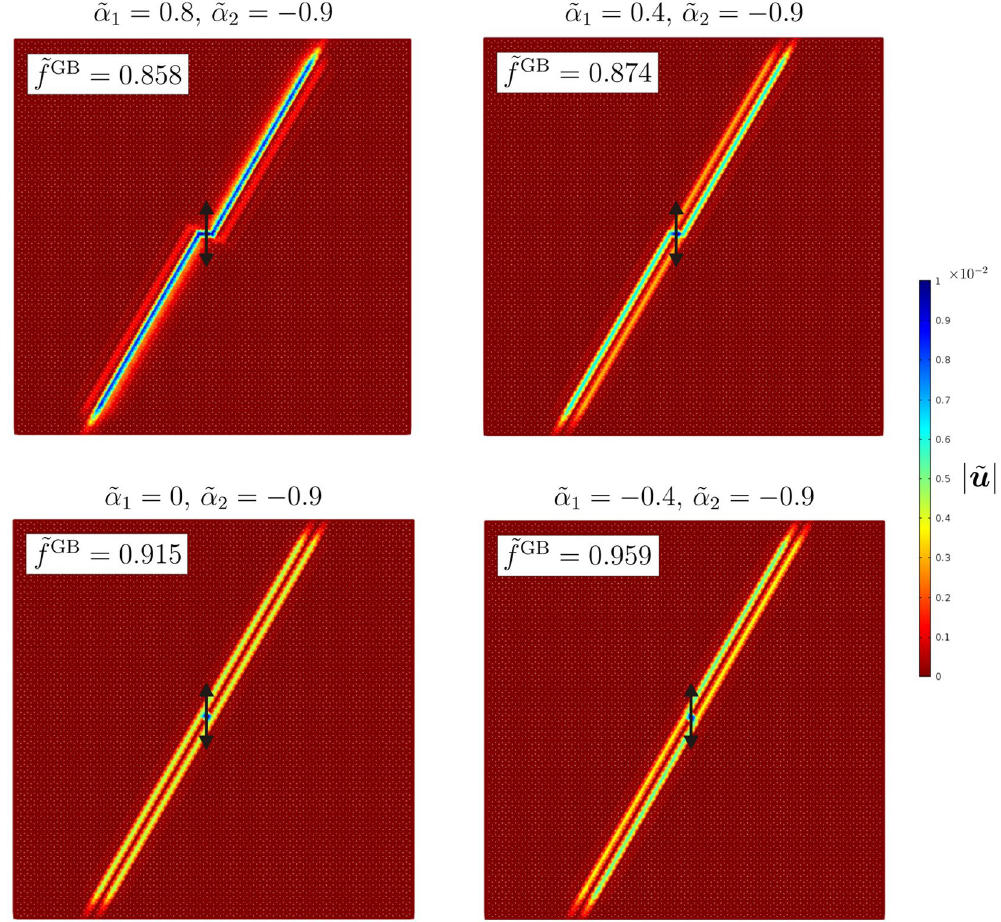
Figure 6. Amplitude fields of the total normalised displacement obtained for different spinner constants, resulting from a vertical harmonic displacement of amplitude 0.01 applied to a node associated with the smaller absolute value of the spinner